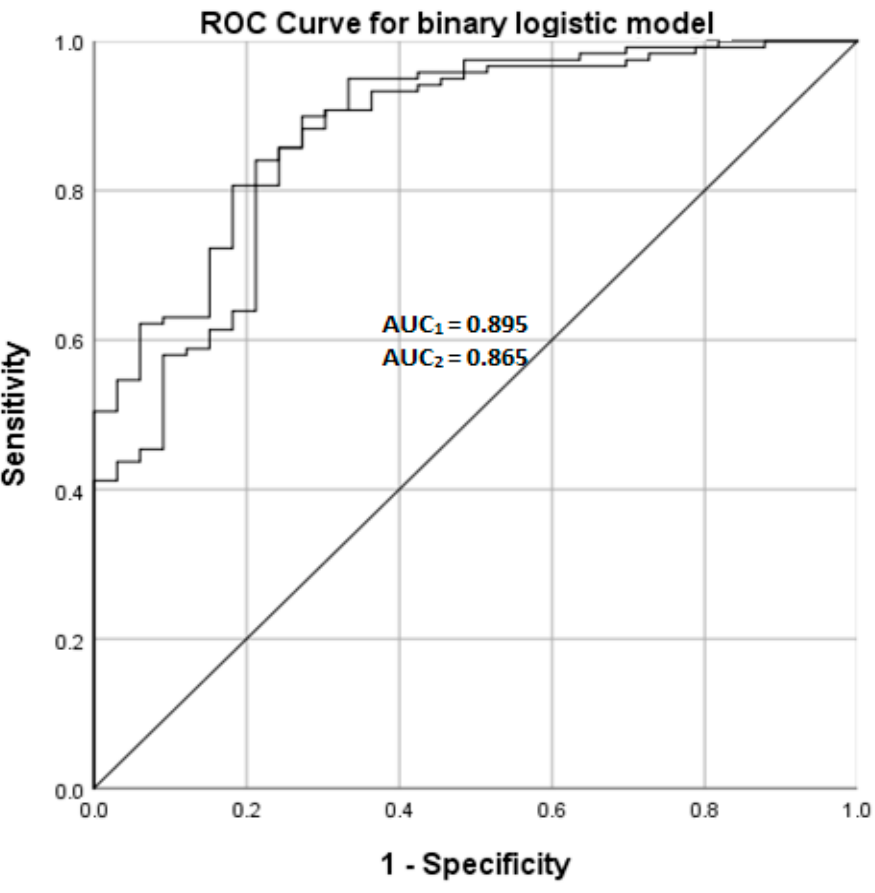
Figure 2. Receiver operating characteristic (ROC) curve for a binary logistic model using LRG, A β 1-42 , and P-Tau 181 (AUC 1 ) and model with A β 1-42 and P-Tau 181 (AUC 2